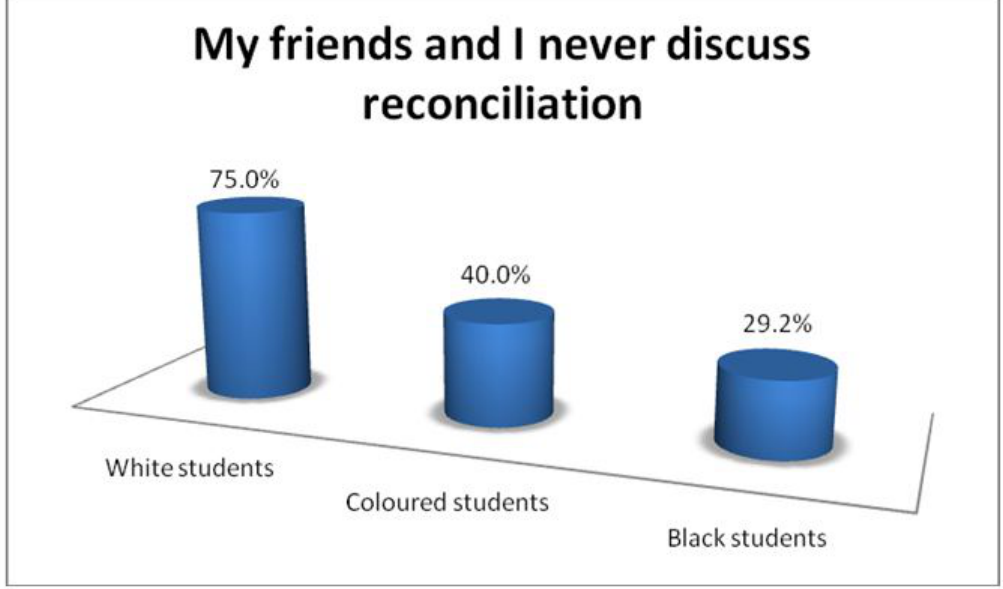
Figure 6: Percentage of students from different racial groupings who admitted to never discussing reconciliation with their